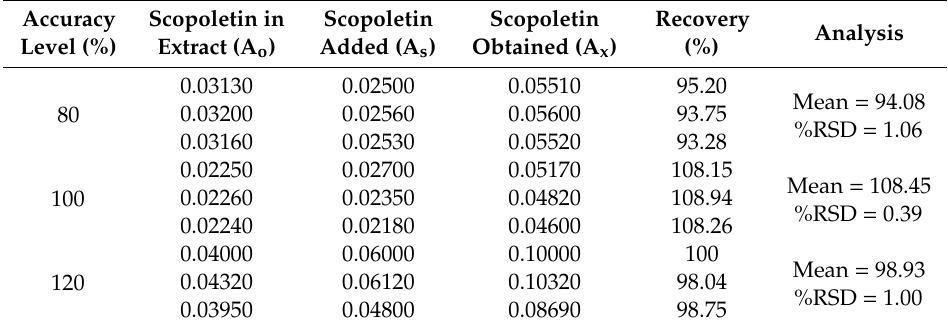
Table 1. Accuracy test results using quantitative nuclear magnetic resonance (qNMR).